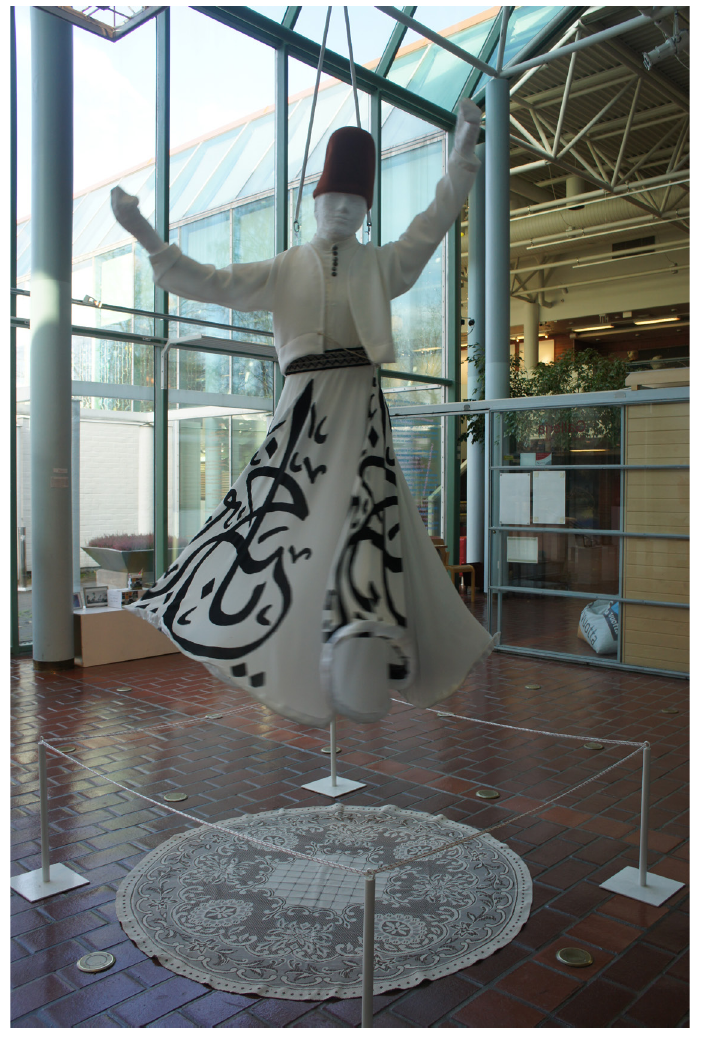
Figure 1. The Sufi-Masa